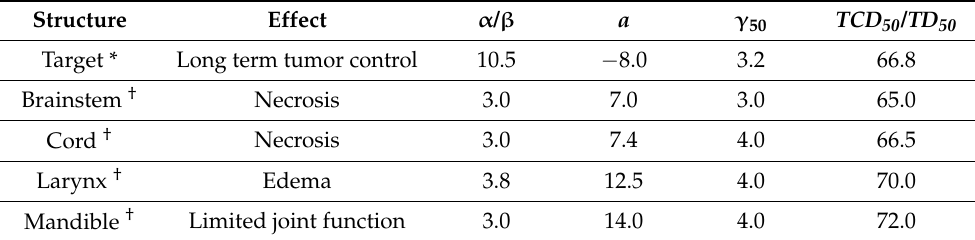
Table 2. Model parameters used for the EUD-based TCP and NTCP